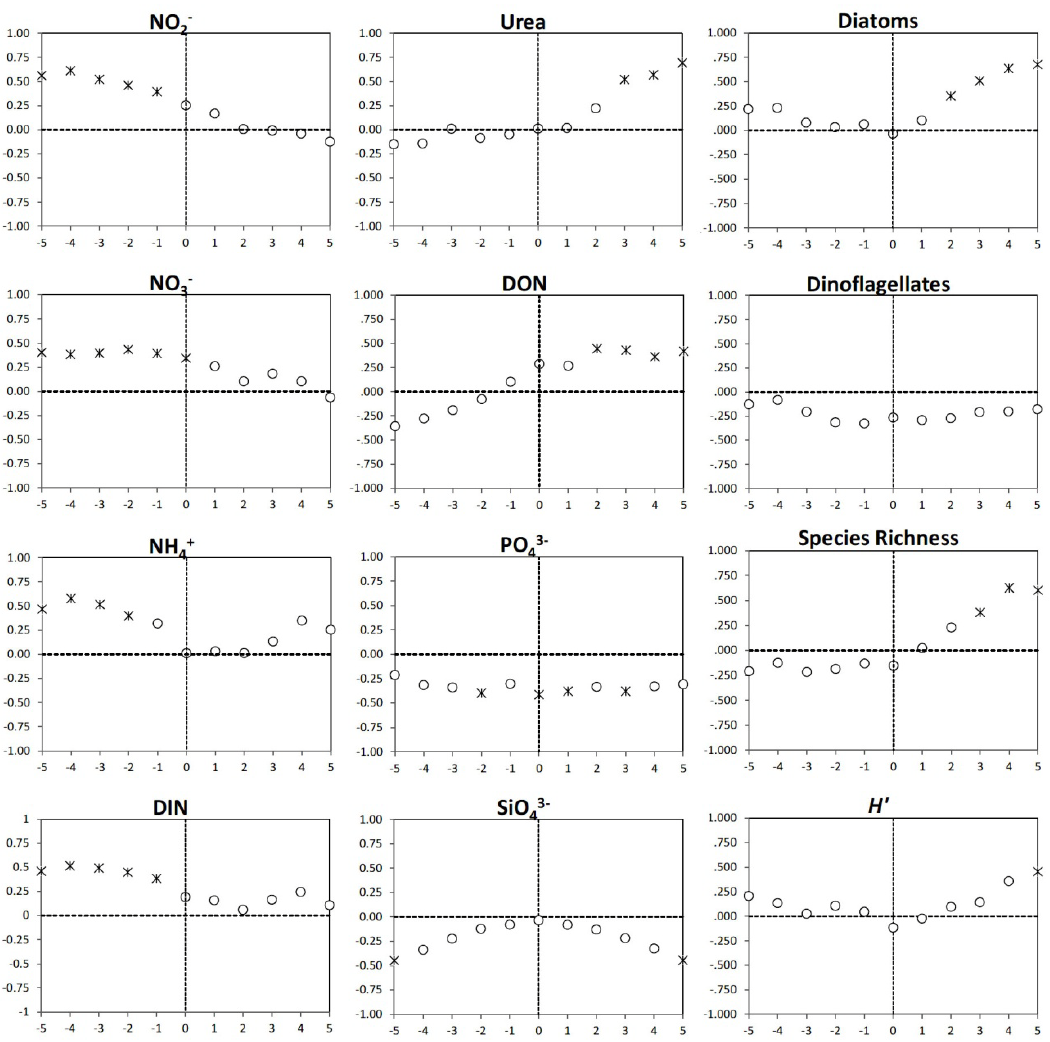
correlations with species richness found 3 to 5 days after the bloom and H ′ five days after the bloom (Figure 7). Figure 7. Time lag Pearson correlation plots of cryptomonad abundance versus nutrient concentrations, diatom abundance, dinoflagellate abundance, phytoplankton species richness and diversity (Shannon index H ′ ). Periods of plus or minus five days are shown on the X -axis with 0 being present. The Pearson correlation coefficient is plotted on the Y -axis, with positive values indicating positive relationships, and negative values negative relationships. Correlations that are statistically significant at the p < 0.05 level are indicated by